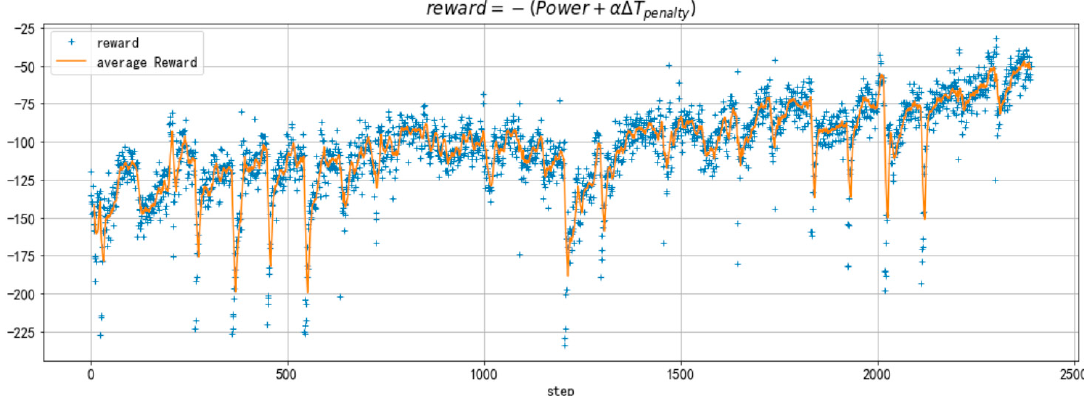
Figure 7. Reward trend of reinforcement learning.